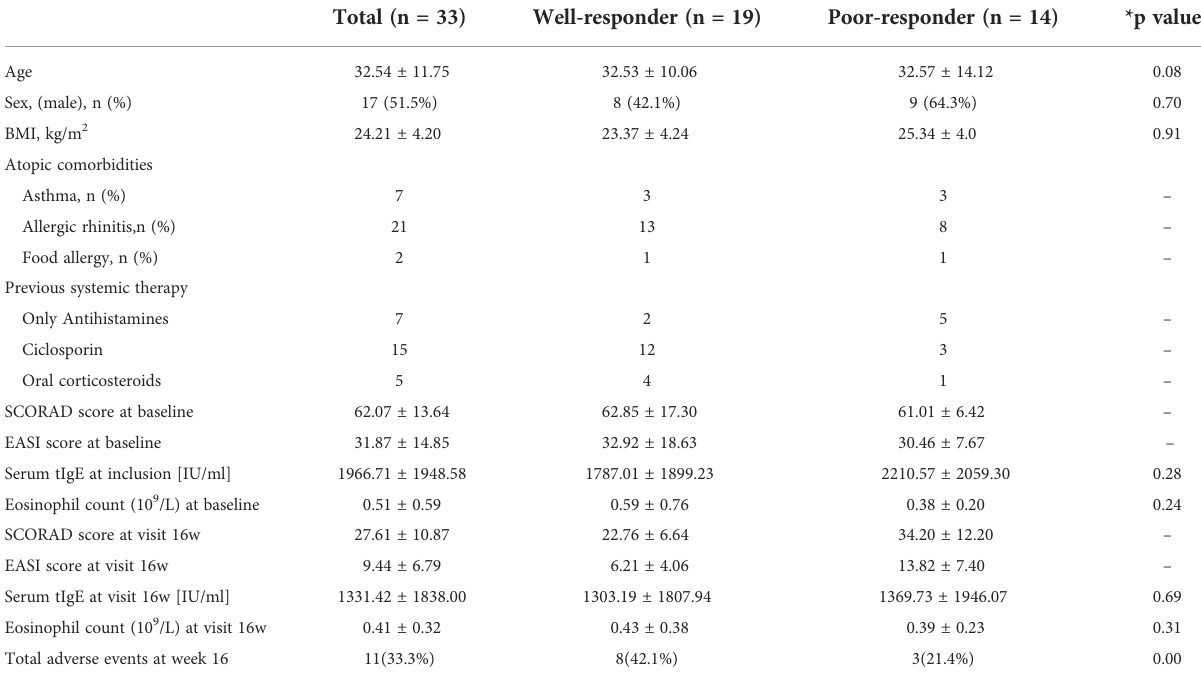
TABLE 1 Characteristic of the study